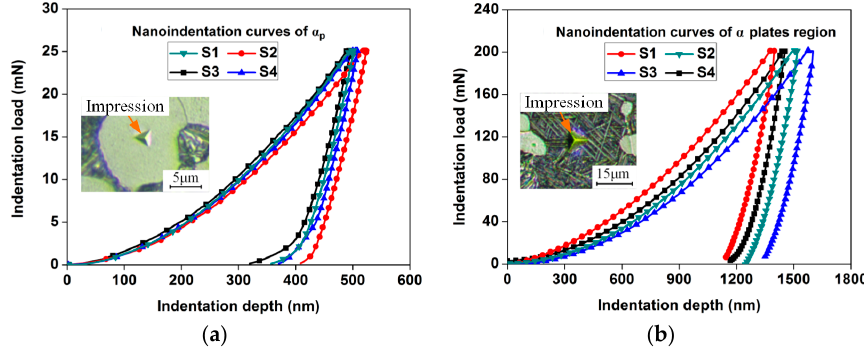
Figure 2. Load-indentation depth curves of different constituent phases: ( a ) α p , ( b ) α plates region.